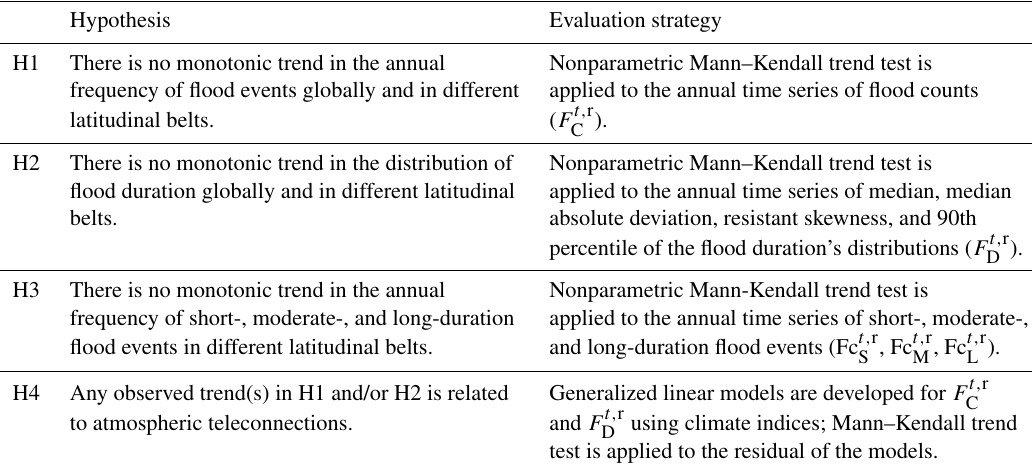
Table 1. Proposed hypotheses and evaluation approach. Hypothesis Evaluation strategy H1 There is no monotonic trend in the annual Nonparametric Mann–Kendall trend test is frequency of flood events globally and in different applied to the annual time series of flood counts latitudinal belts. ( F t, r ). C H2 There is no monotonic trend in the distribution of Nonparametric Mann–Kendall trend test is flood duration globally and in different latitudinal applied to the annual time series of median, median belts. absolute deviation, resistant skewness, and 90th percentile of the flood duration’s distributions ( F t, r ). D H3 There is no monotonic trend in the annual Nonparametric Mann-Kendall trend test is frequency of short-, moderate-, and long-duration applied to the annual time series of short-, moderate-, flood events in different latitudinal belts. H4 Any observed trend(s) in H1 and/or H2 is related Generalized linear models are developed for F t, r C to atmospheric